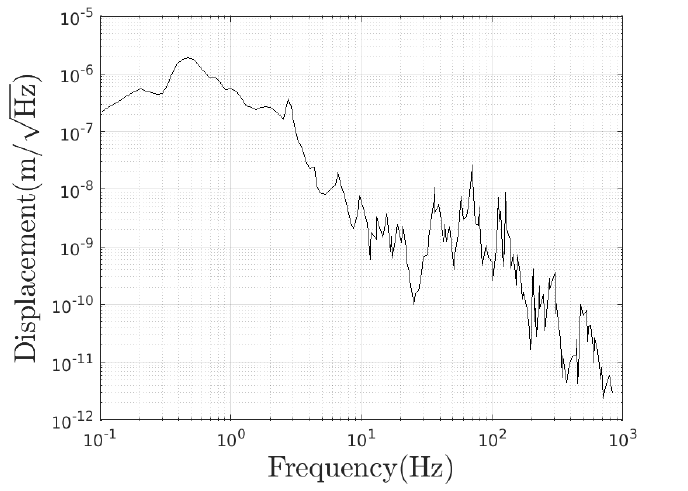
Figure 12. Cryobaffle displacement at a 50% percentile, obtained from Figure 22 in Ref. [18].